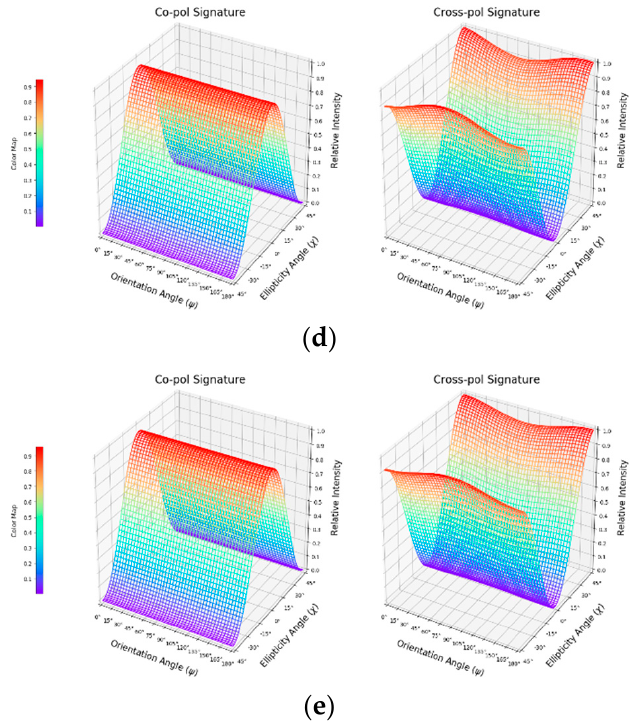
Figure 6. The S-band polarimetric signatures for ( a ) CR 23, ( b ) CR 24, ( c ) CR 25, ( d ) CR 26, and ( e ) CR 27.